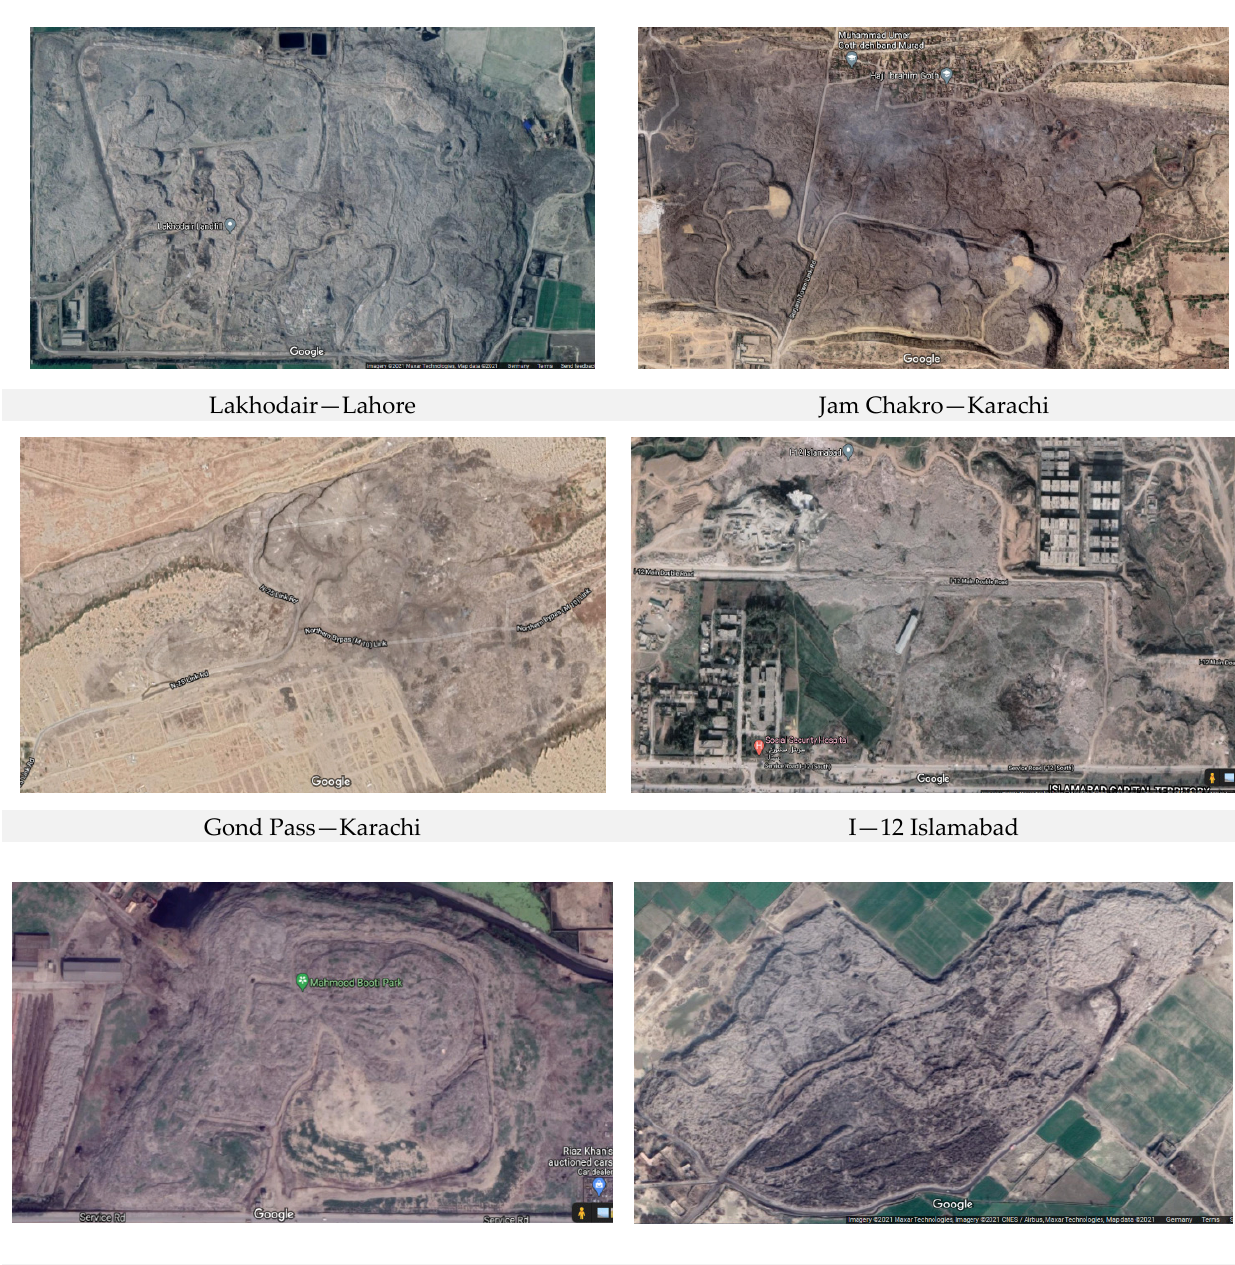
Figure 4. Aerial views of MSW disposal sites in major cities in Pakistan (Google maps).